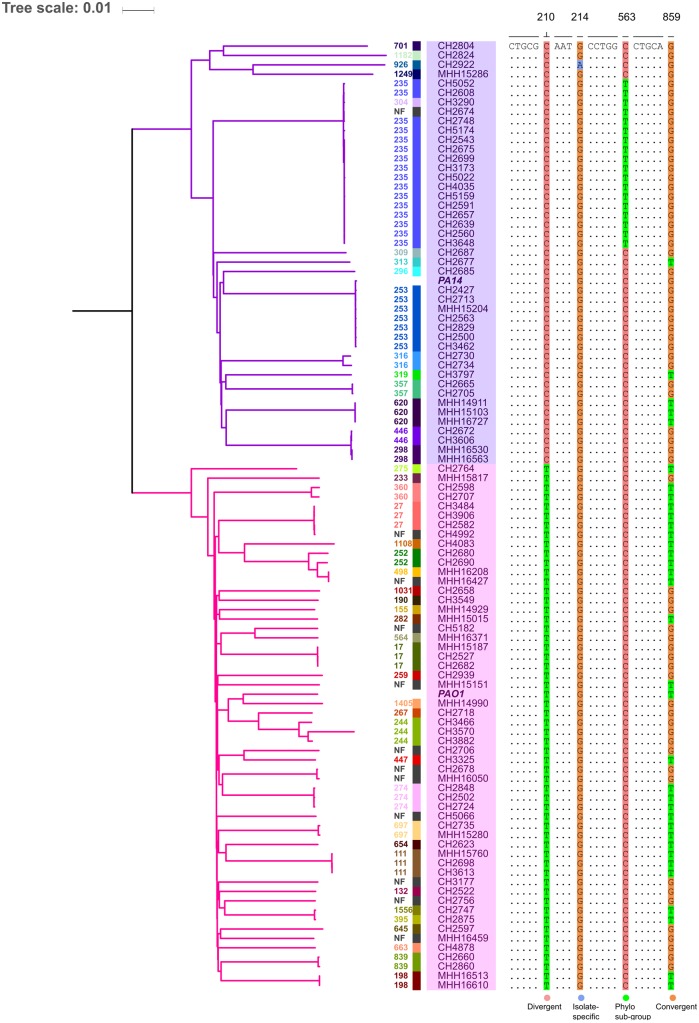
—Classification of SNPs across isolates. The rooted phylogenetic tree (on the left) reflects the ST-specific information in two major groups. On the right, four nucleotide positions 210, 214, 563, and 859 of PA14_00190 serve as an example to demonstrate the different classes of SNPs. At position 210, the SNP is 100% divergent; at position 214, there is an isolate-specific SNP, that is, present only in isolate-CH2922; at position 563, a phylogenetic subgroup specific SNP present in PA14 phylogroup and absent in PAO1 phylogroup; and at position 859, the SNP is commonly identified in the clinical isolates and is found independent on the phylogenetic background (convergent).